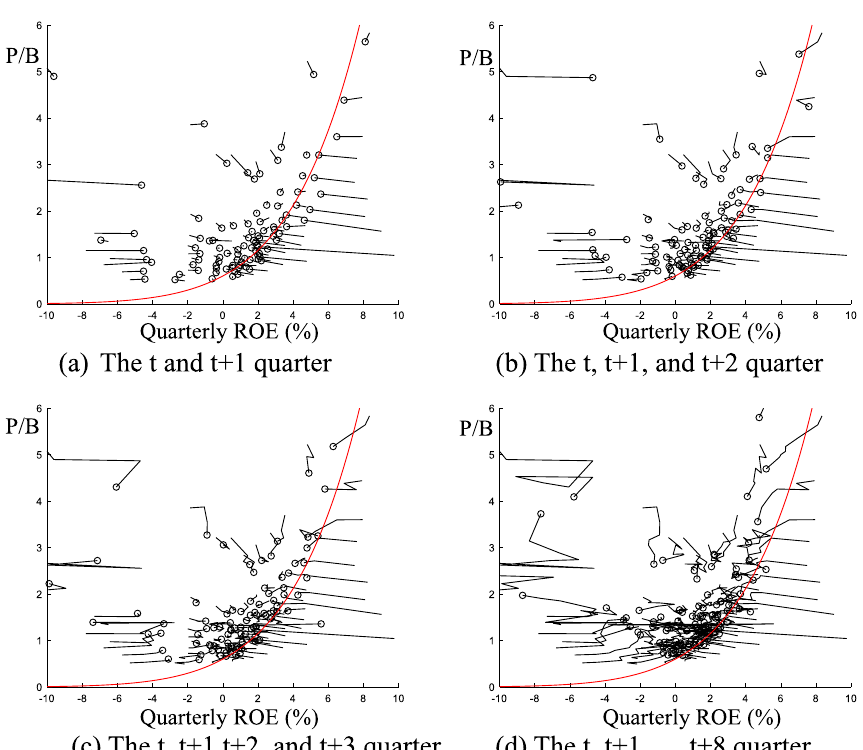
Fig. 13 The movement path of ROE (X axis) and P/B (Y axis) in the current quarter and the subsequent 1, 2, 3, and 8 quarters: High risk